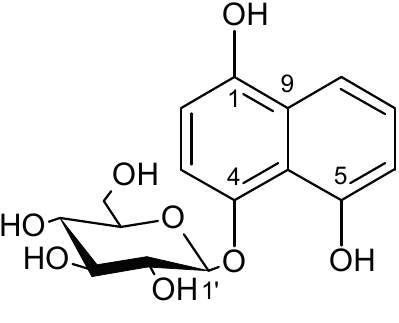
Figure 2. Structure of hydrojuglone glucoside ( 1